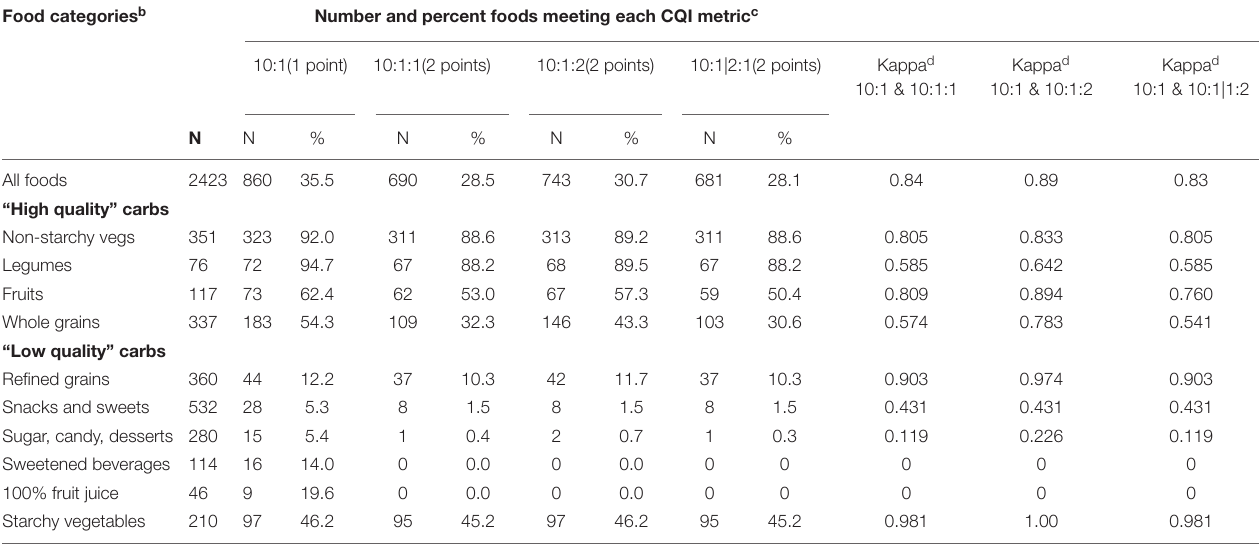
TABLE 3 | Comparison of carbohydrate-rich foods in the US meeting each of four metrics for assessing carbohydrate quality a . Food categories b